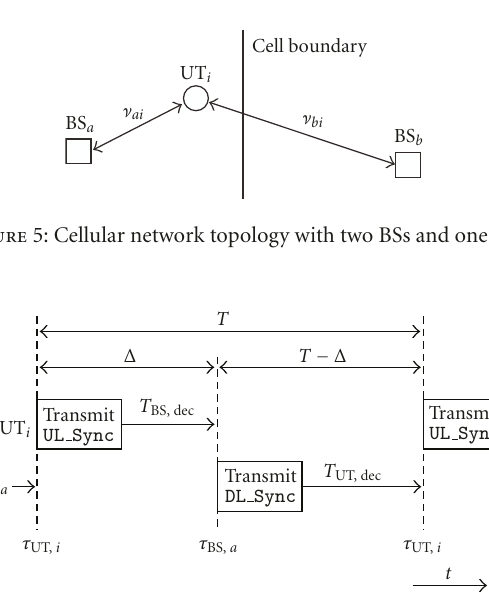
Figure 6: Synchronization principle of